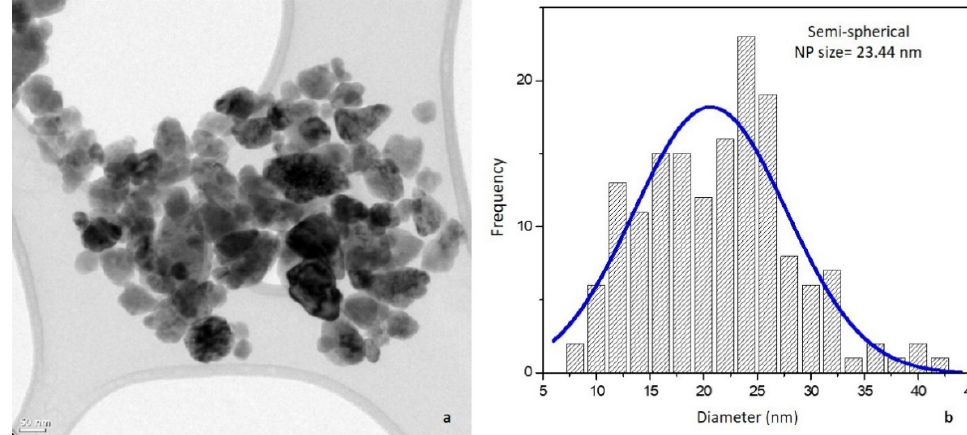
Figure 1. Transmission electron microscopy micrograph showing the semi-spherical morphology of ZnO-NPs ( a ) and histogram of particle size distribution ( b ).